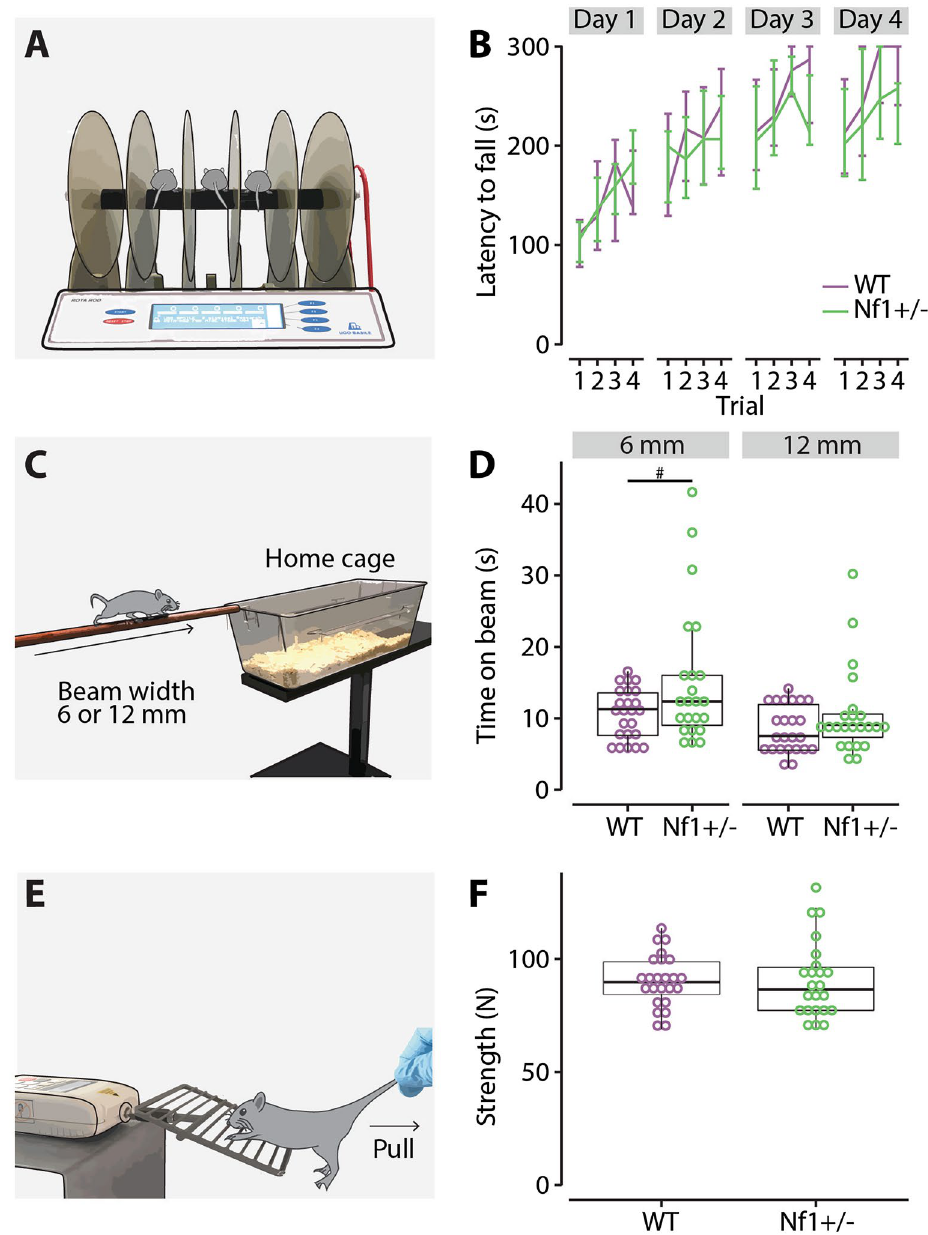
Figure 5. Performance on the accelerated rotarod, balance beam and grip test. ( A ) Illustration of the accelerating rotarod test, where mice are placed on an accelerating rotating rod. The latency to fall on the lever below the rod is measured up to 300 s. ( B ) Lines represent the median latency to fall (s) per genotype, with the whiskers displaying the interquartile range. ( C ) Illustration of the balance beam test, where it was timed how long mice took to walk from start to end on two beam widths (6 mm and 12 mm). ( D ) Box plots of the median time on beam per beam width and genotype (s). Each dot represents the median of a single mouse over two trials. ( E ) Illustration of the grip test, where the max strength (N) is measured a mouse uses to grab onto a grid before it lets go. ( F ) Boxplots of the median strength per genotype. Each dot represents the median of an individual mouse over eight